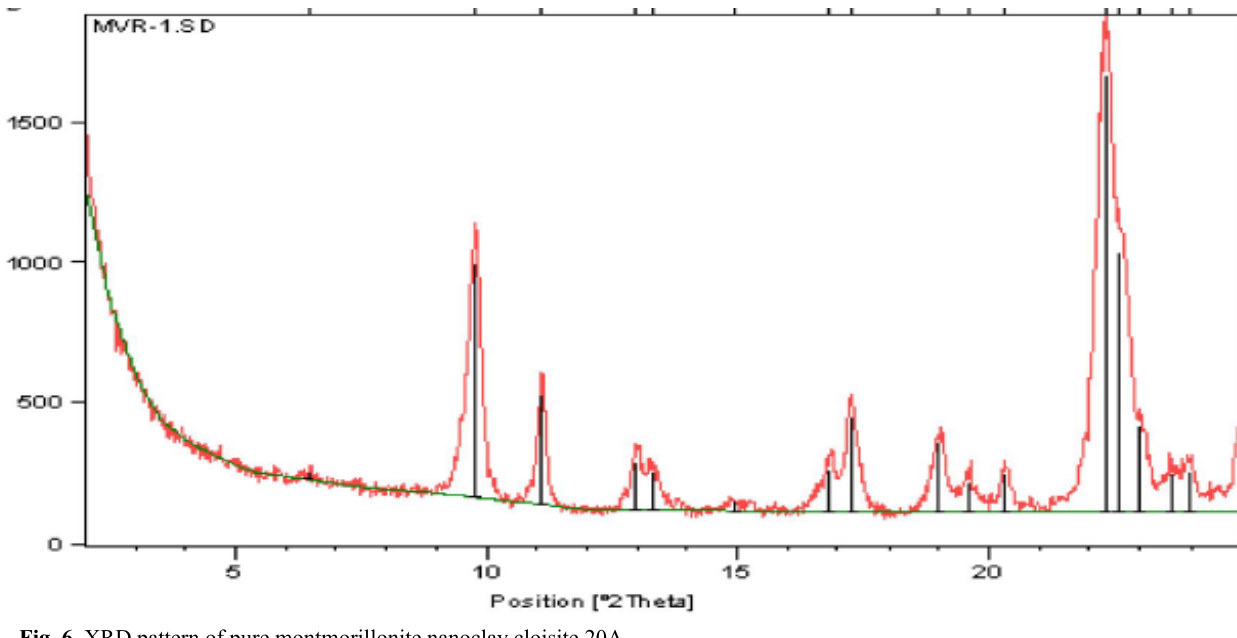
20A.Fig. 6. XRD pattern of pure montmorillonite nanoclay cloisite